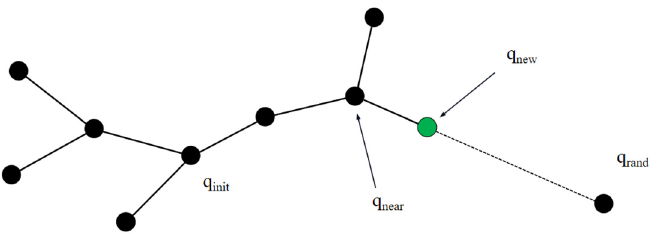
Figure 1. Schematic illustration of the expansion steps of the RRT algorithm. The RRT algorithm performs random sampling in the state space to obtain q rand , and the vertex closest to q rand is calculated as q near . Then, the random tree of RRT extends a certain distance from q near to q rand to obtain q new .